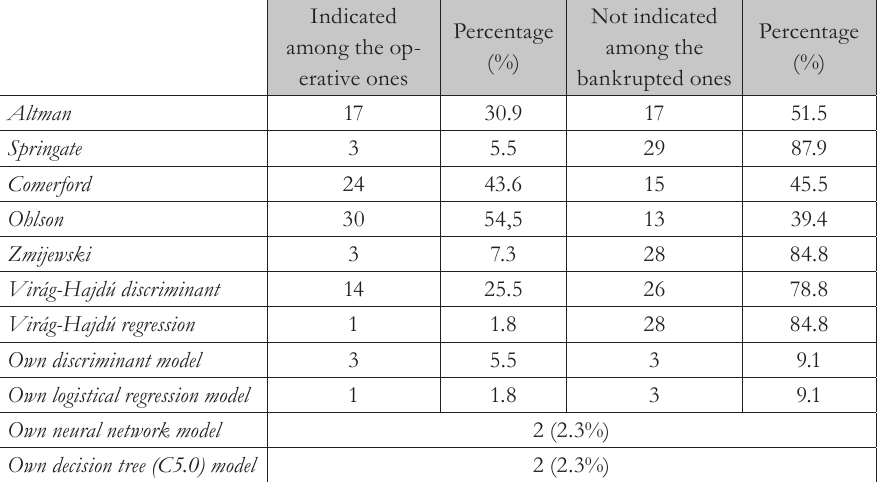
Tab. 3 – The failure values of the crisis management’s models, projected onto the initial sample. Source: own construction.